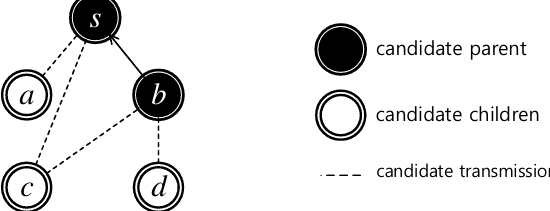
Figure 4. The conflict degrees of candidate transmissions: l L ( a , s ) = 2, l L ( c , s ) = l L ( c , b ) = 3 and l L ( d , b ) = 2.